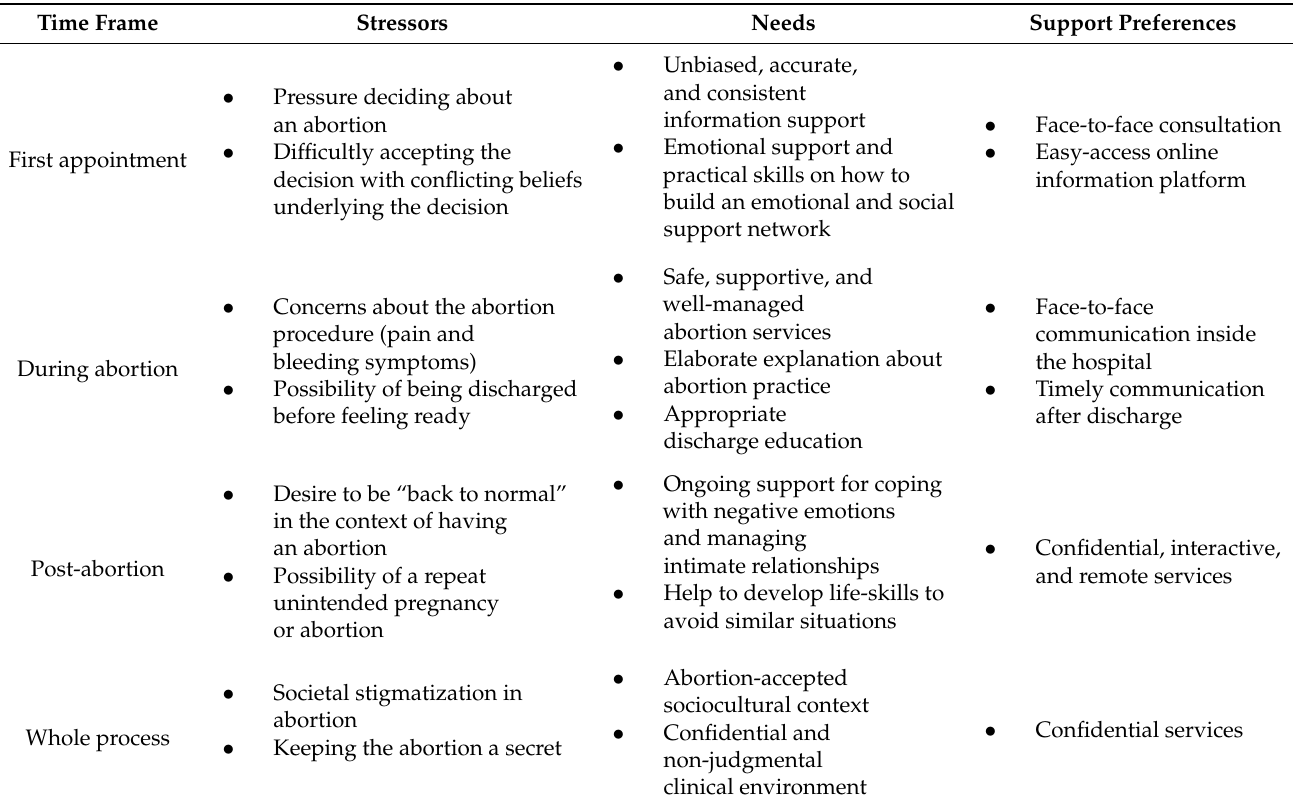
Table 2. Stressors, needs, and support preferences of Chinese women undergoing